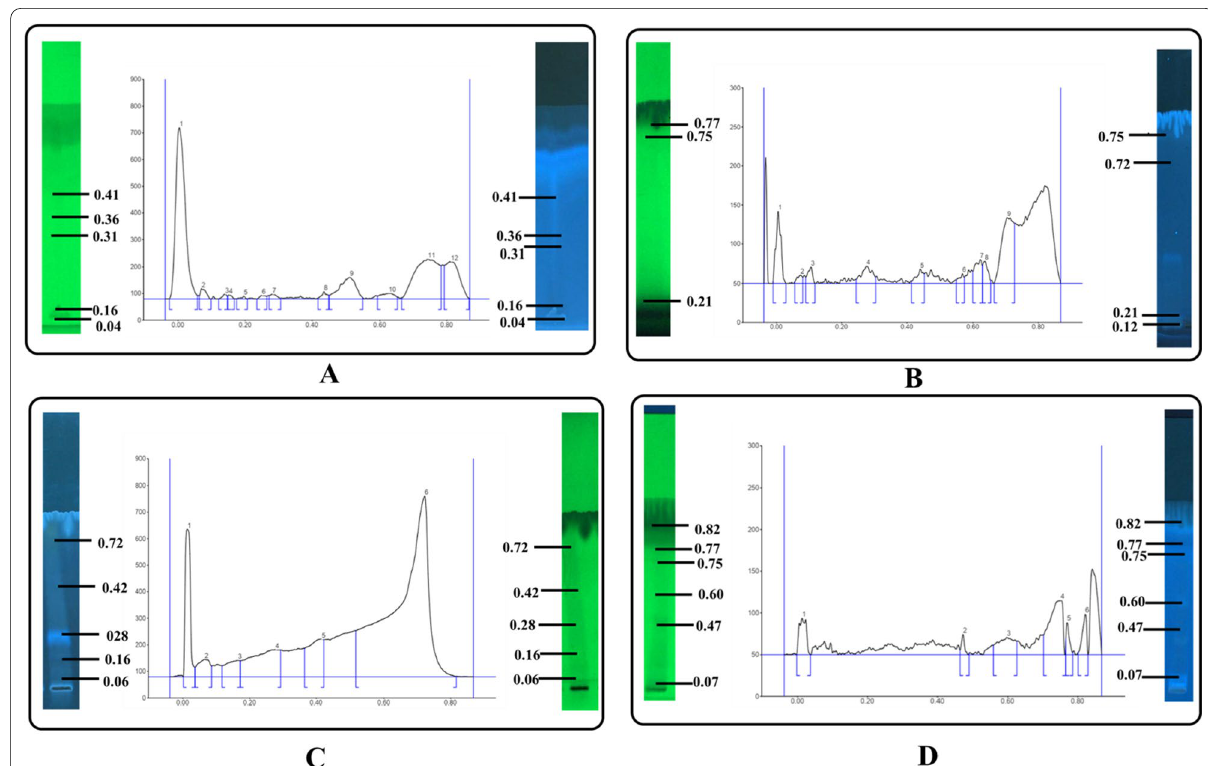
Fig. 8 HPTLC fingerprint chromatogram of BPSAL in Mobile Phase A CHCl 3 :C 2 H 5 OH [9.8:0.2]) C Toluene: Ethyl acetate: Glacial acetic acid [5:7:1]) and BPSAQ in Mobile Phase ( B ) Toluene: Ethyl acetate: Glacial acetic acid [5:7:1], D CHCl 3 : CH 3 OH [95:5])